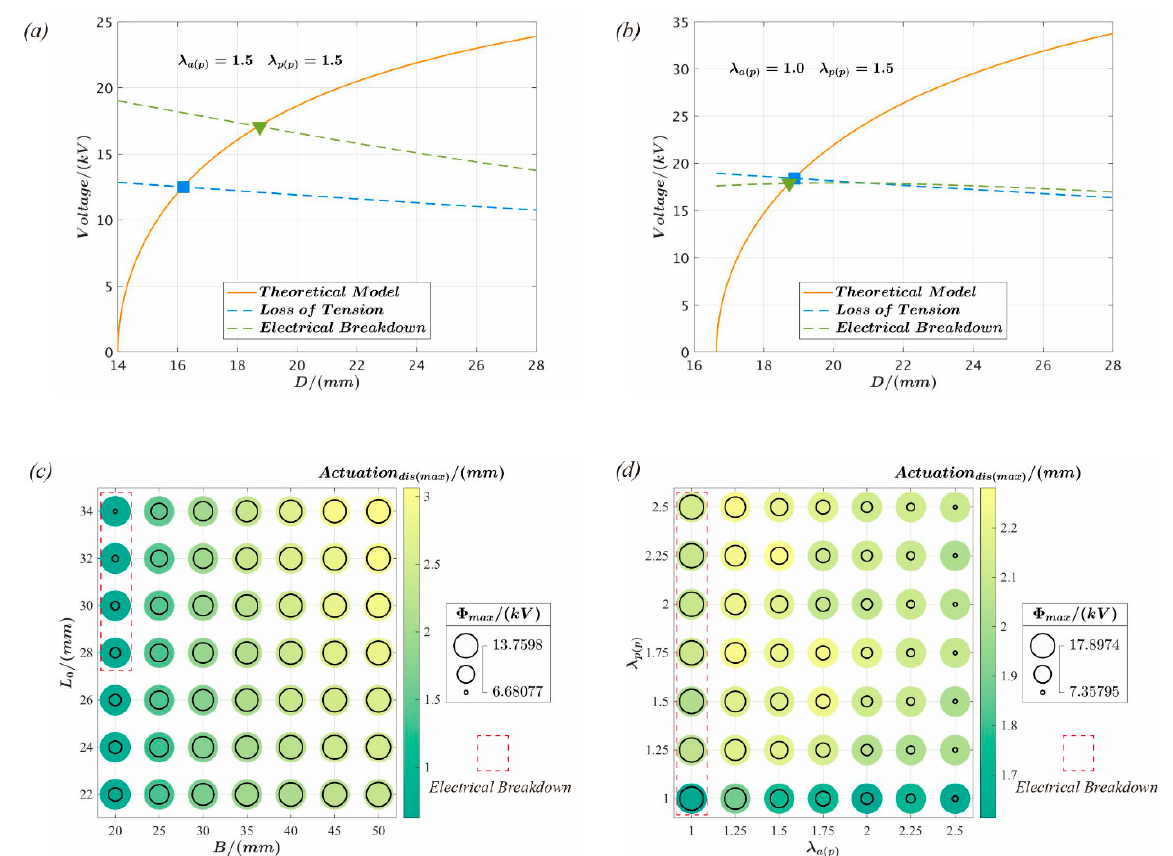
Figure 5. The influence law of key design parameters on the maximum actuation deformation and critical failure voltage of the actuator. ( a , b ) show the different types of failures that can occur with different parameter combinations, where ( a ) produces loss of tension failure and ( b ) produces electrical breakdown failure. The blue square represents a loss of tension in the actuation, while the green triangle indicates electrical breakdown that occurred during the actuation process; ( c , d ) provide the maximum actuation displacement and the critical voltage for actuator’s failure with different parameter combinations, respectively.